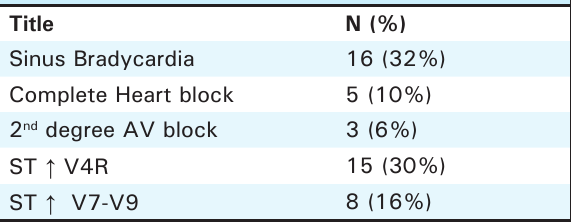
Table 2. Common complications noted in study